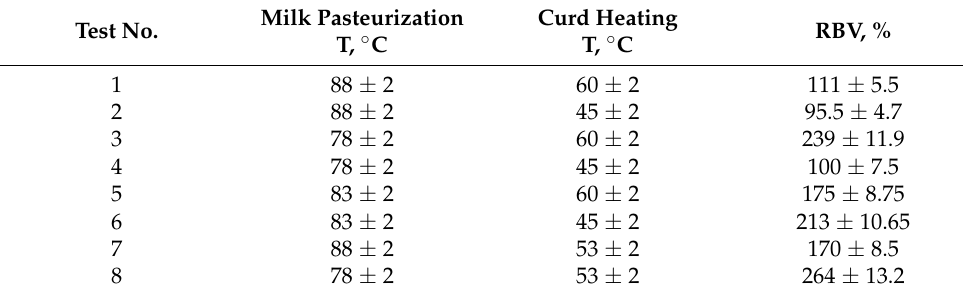
Table 7. Full factorial quadratic experiment design.